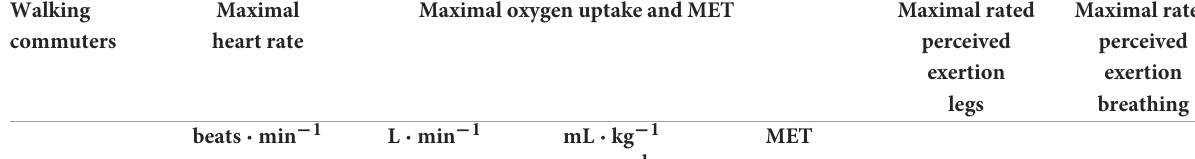
TABLE 4 Maximal values of heart rate, oxygen uptake, MET and rated perceived exertion in maximal treadmill running (mean, SD and 95% CI). Walking